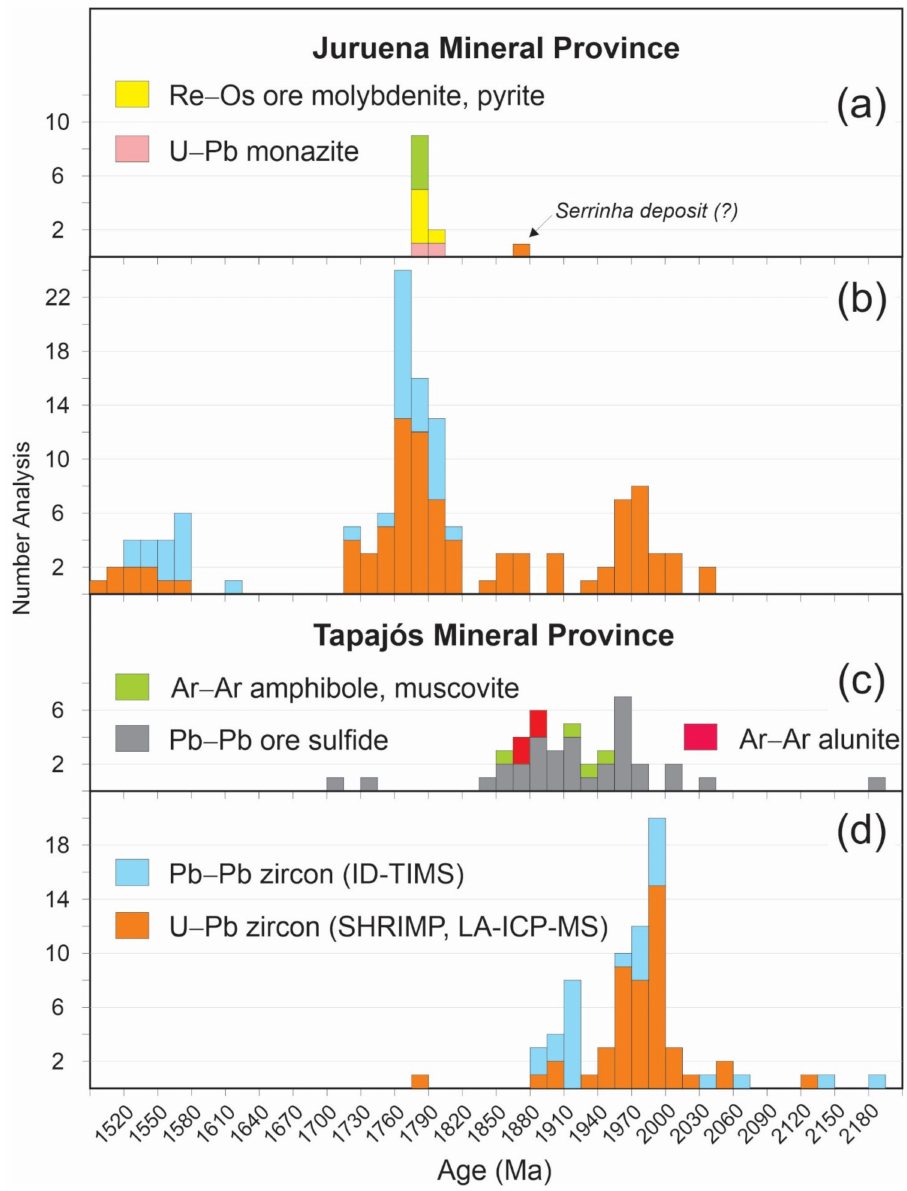
Figure 8. Geochronological data and distribution of magmatism and gold mineralization ages in the TPM and JMP. ( a ) Mineralization timing based on Re–Os molybdenite and chalcopyrite, Ar–Ar in muscovite/sericite, and U–Pb monazite ages from the JMP; ( b ) Magmatic events ages of the JMP; ( c ) Pb–Pb model ages for sulfides from TMP gold veins and alunite Ar–Ar ages from the Botica Velha (V3) high-sulfidation Au–Ag mineralization; ( d ) Magmatic events ages of the TMP. Data source: